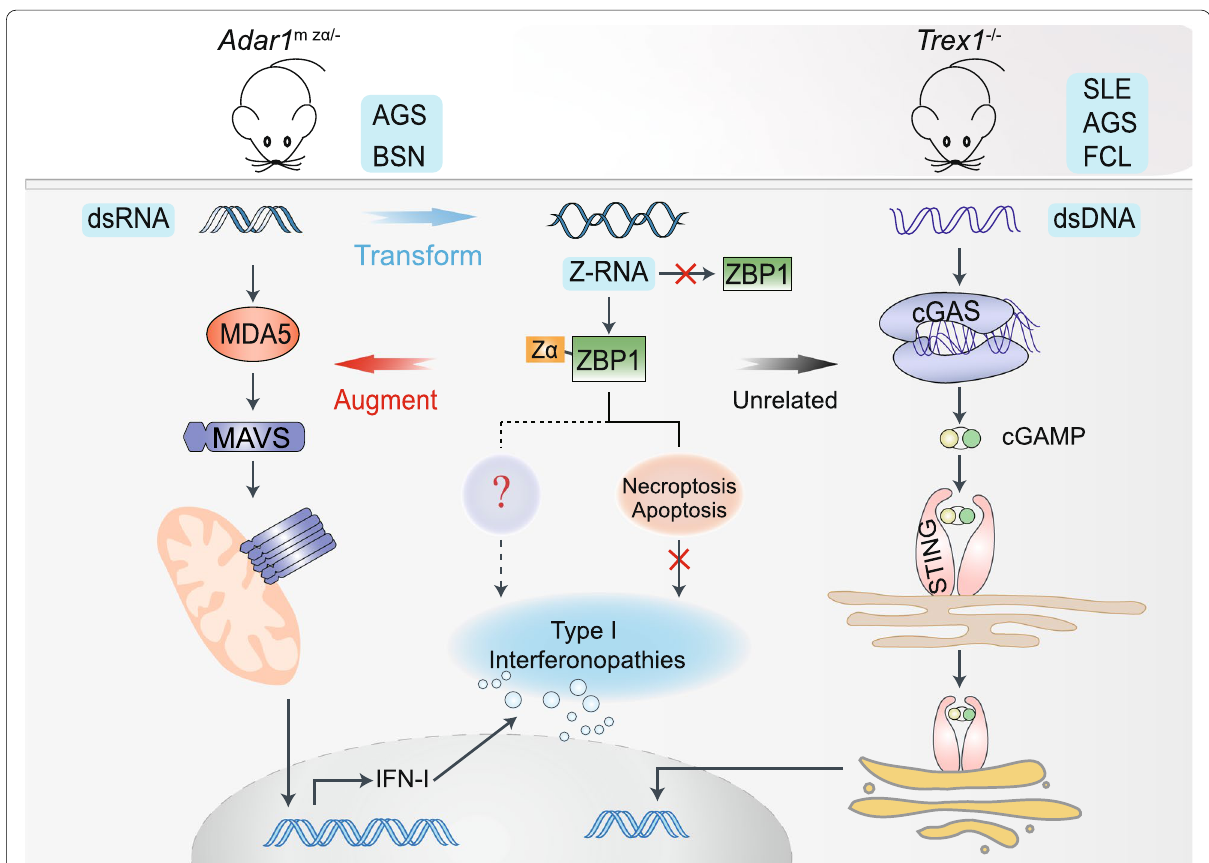
Fig. 1 The contributing role of ZBP1 in pathogenic IFN response in the Adar1 m zα /– model. Hemizygous expression of ADAR1 with a mutated Zα domain resulted in the accumulation of dsRNA and induced a strong MAVS‑dependent type I IFN response, causing the severe postnatal lethality phenotype in mice. These dsRNA with the ability to transform into Z‑RNA recognized by the Zα domain of ZBP1 augment the type I